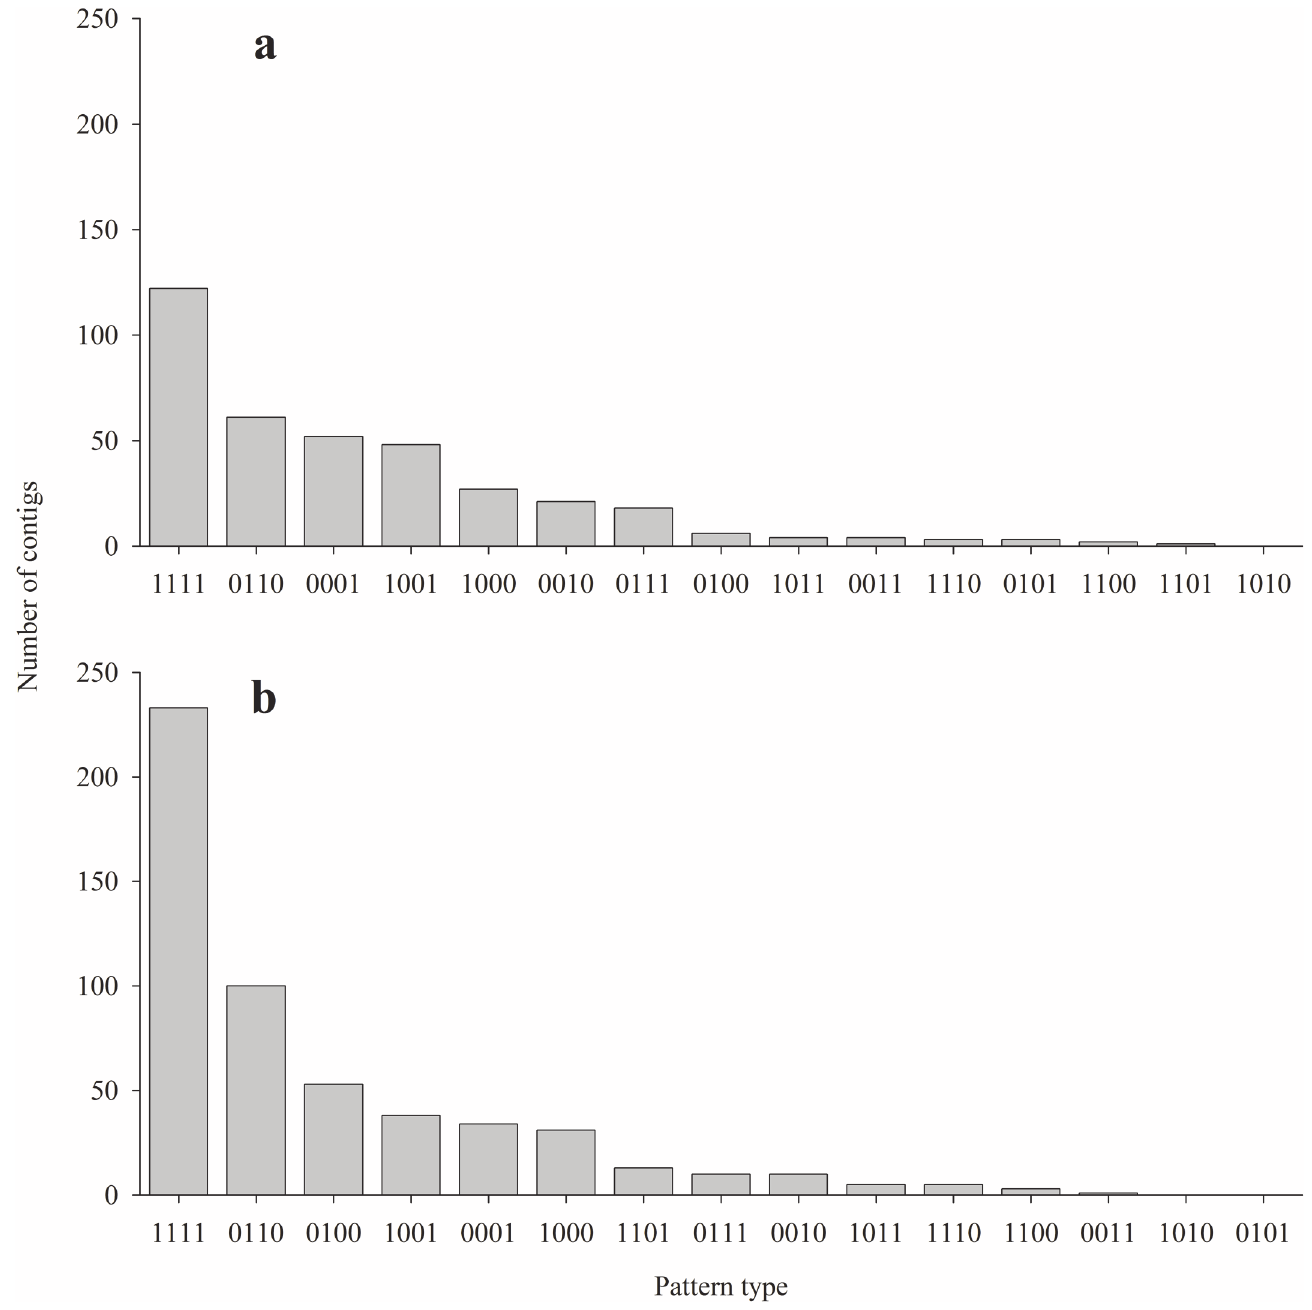
Fig 2. Number of contigs in each binary pattern. (a) Gastrolith-forming epithelium samples and (b) mandible cuticle-forming epithelium samples. Patterns are arranged by abundance, from most to least abundant. A representative example of the binary pattern code is shown in Fig 1.